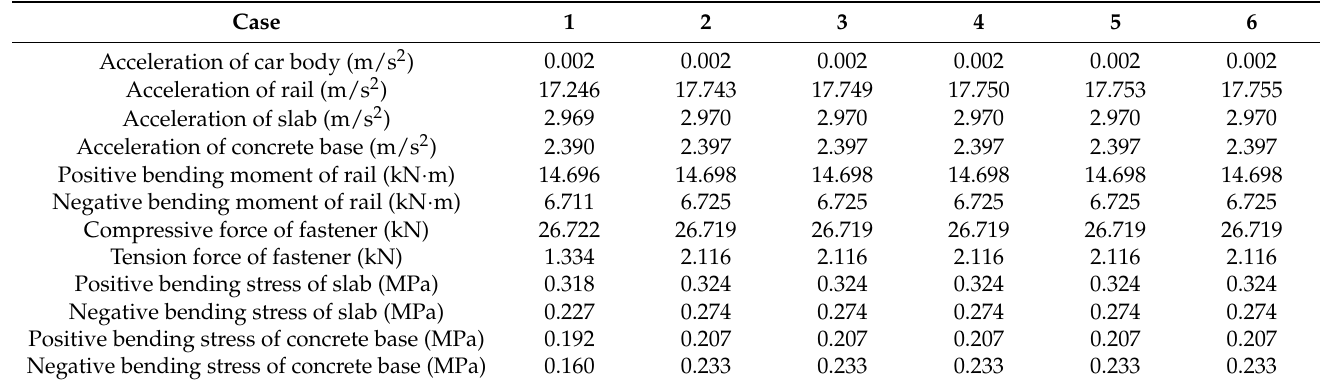
Table 5. Largest dynamic responses for Cases 1–6.